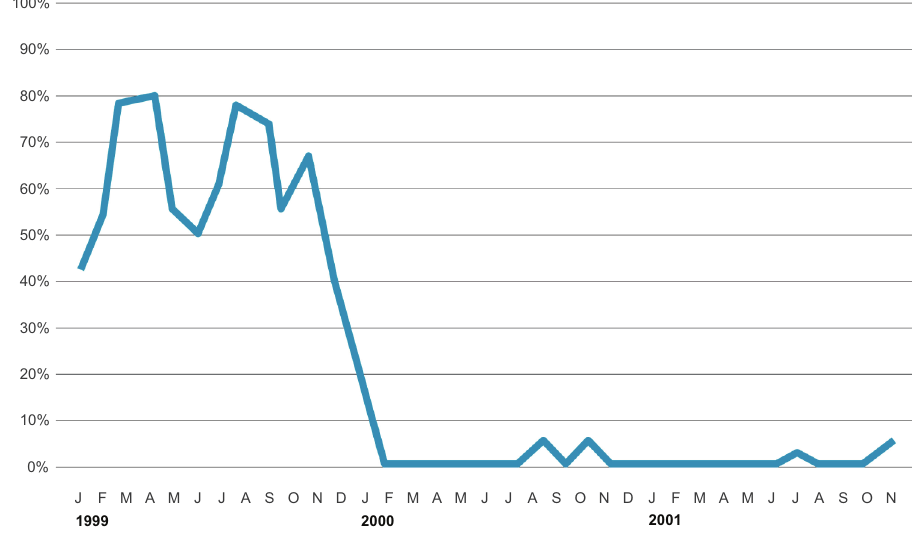
Figure 2. Tver Oblast, Russia: neonates arriving to the neonatal intensive care units (NICU) center with hypothermia. As a result of the neonatal transport system, the percentage of neonates referred to the NICU with abnormally low body temperature was significantly reduced. This improves the survival of newborns with respiratory distress